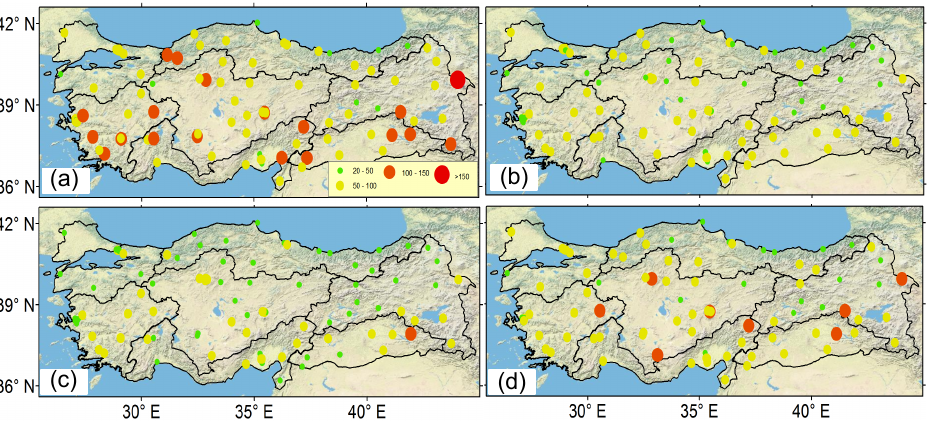
Figure 2. The long-term (2010–2015) mean of the seasonal PM 10 concentrations ( μ g·m − 3 ) related to 97 air quality stations. ( a ) Winter, ( b ) Spring, ( c ) Summer, and ( d ) Fall seasons, respectively.